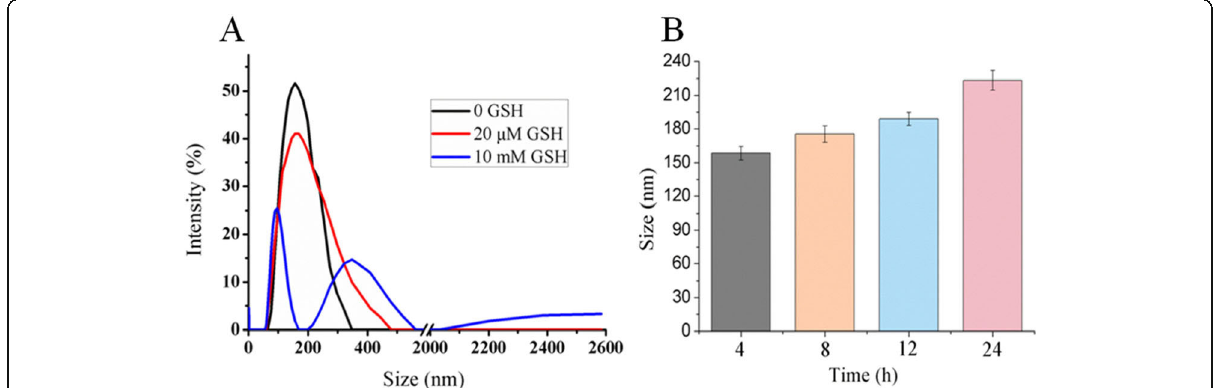
Fig. 6 The stability of CUR-BCSC@PCs. a Size changes of CUR-BCSC@PCs at different GSH concentration. b Size changes of CUR-BCSC@PCs in PBS at different